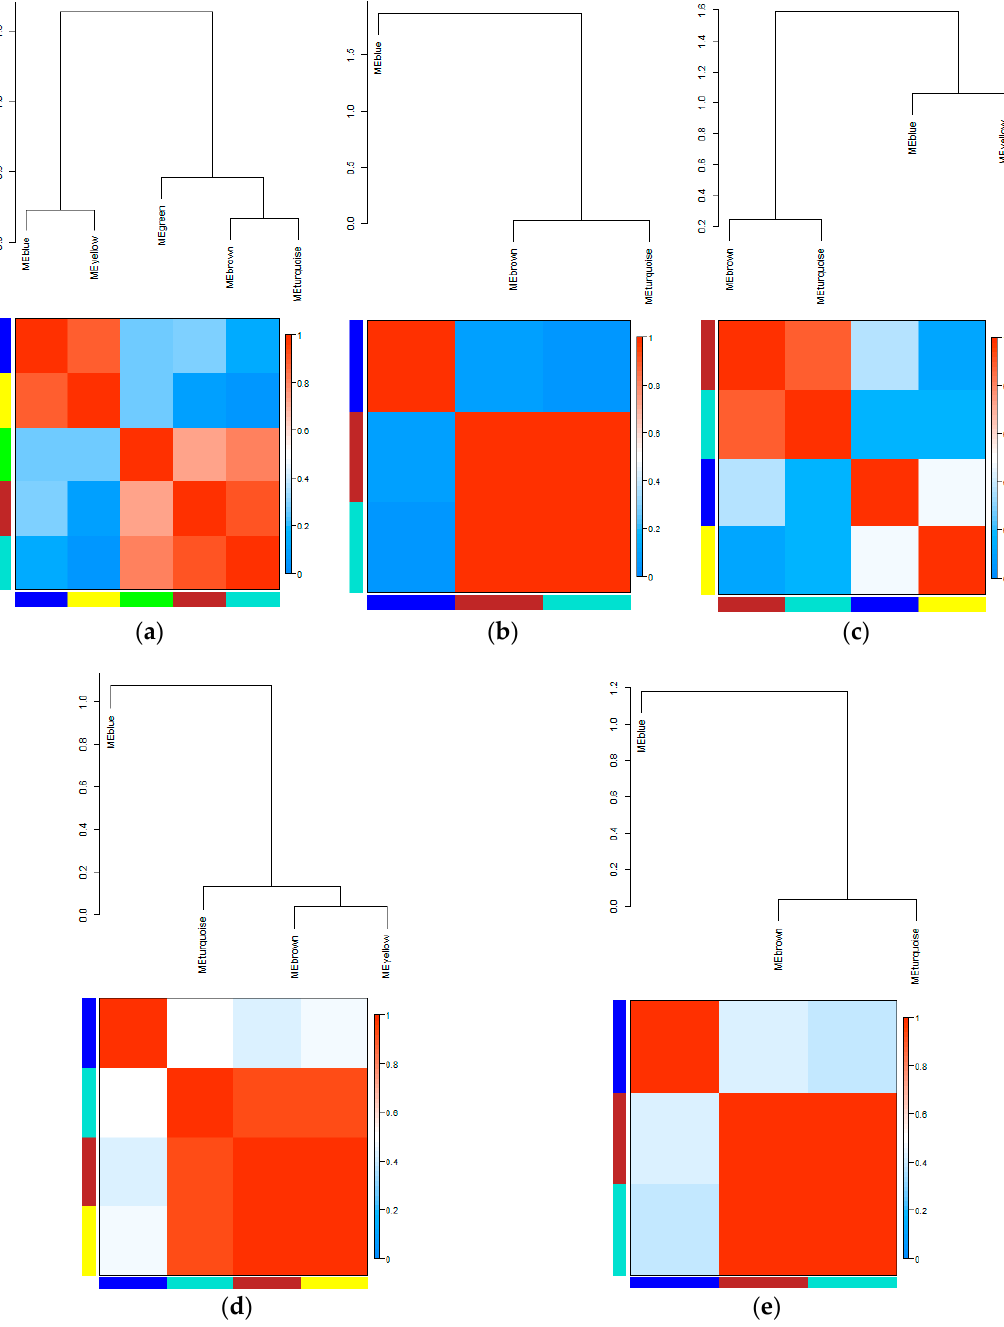
Figure 7. Correlations and heatmap of module eigengenes of the five networks: ( a ) network C; ( b ) network L; ( c ) network M; ( d ) network H; ( e ) network E.